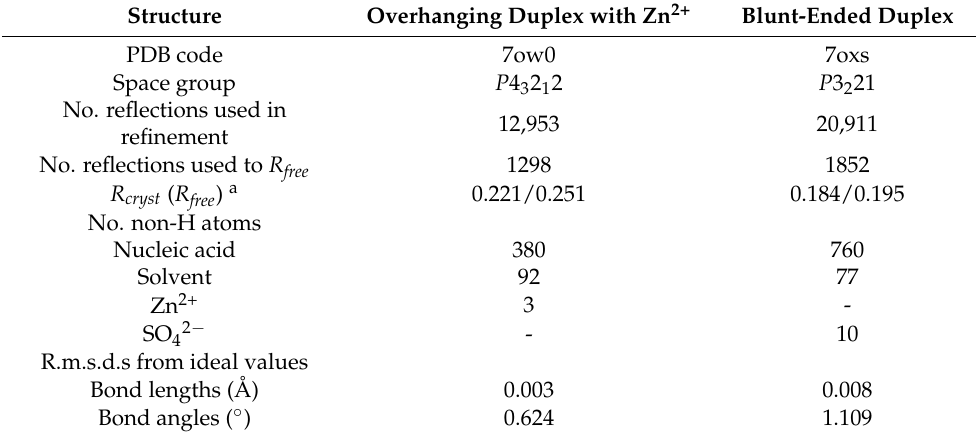
Table 2. Refinement statistics of the studied structures. The values in parentheses correspond to the highest resolution shell. Structure Overhanging Duplex with Zn 2+ Blunt-Ended